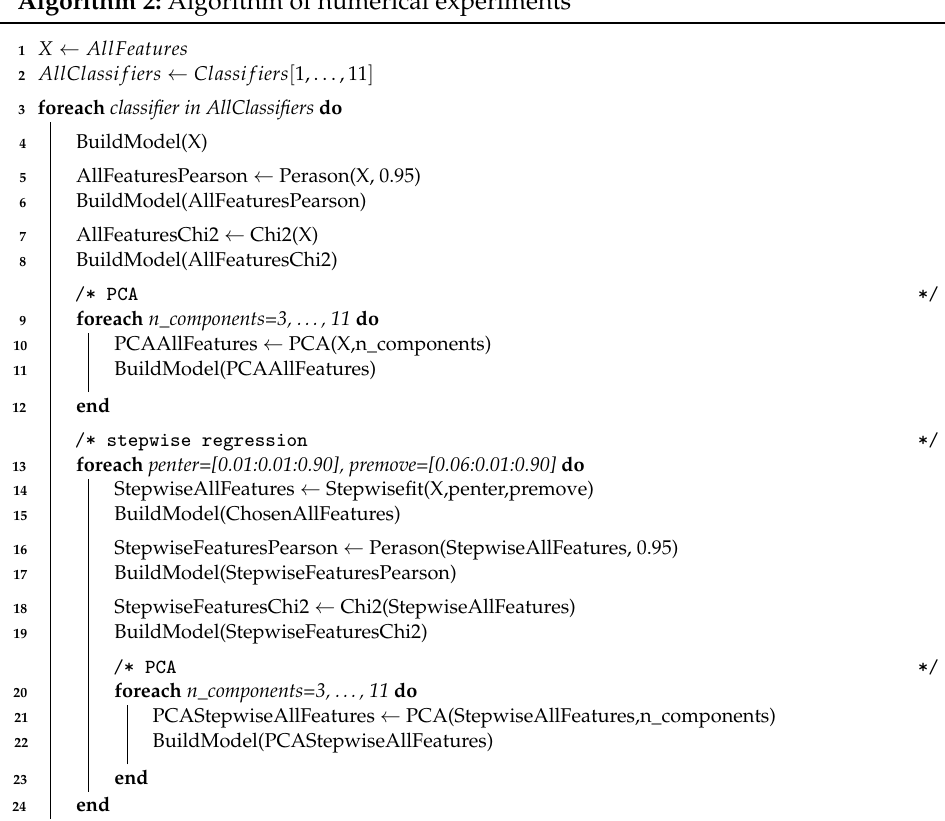
Figure 6. Result of blueberry crop prediction for test and validation. Algorithm 2: Algorithm of numerical